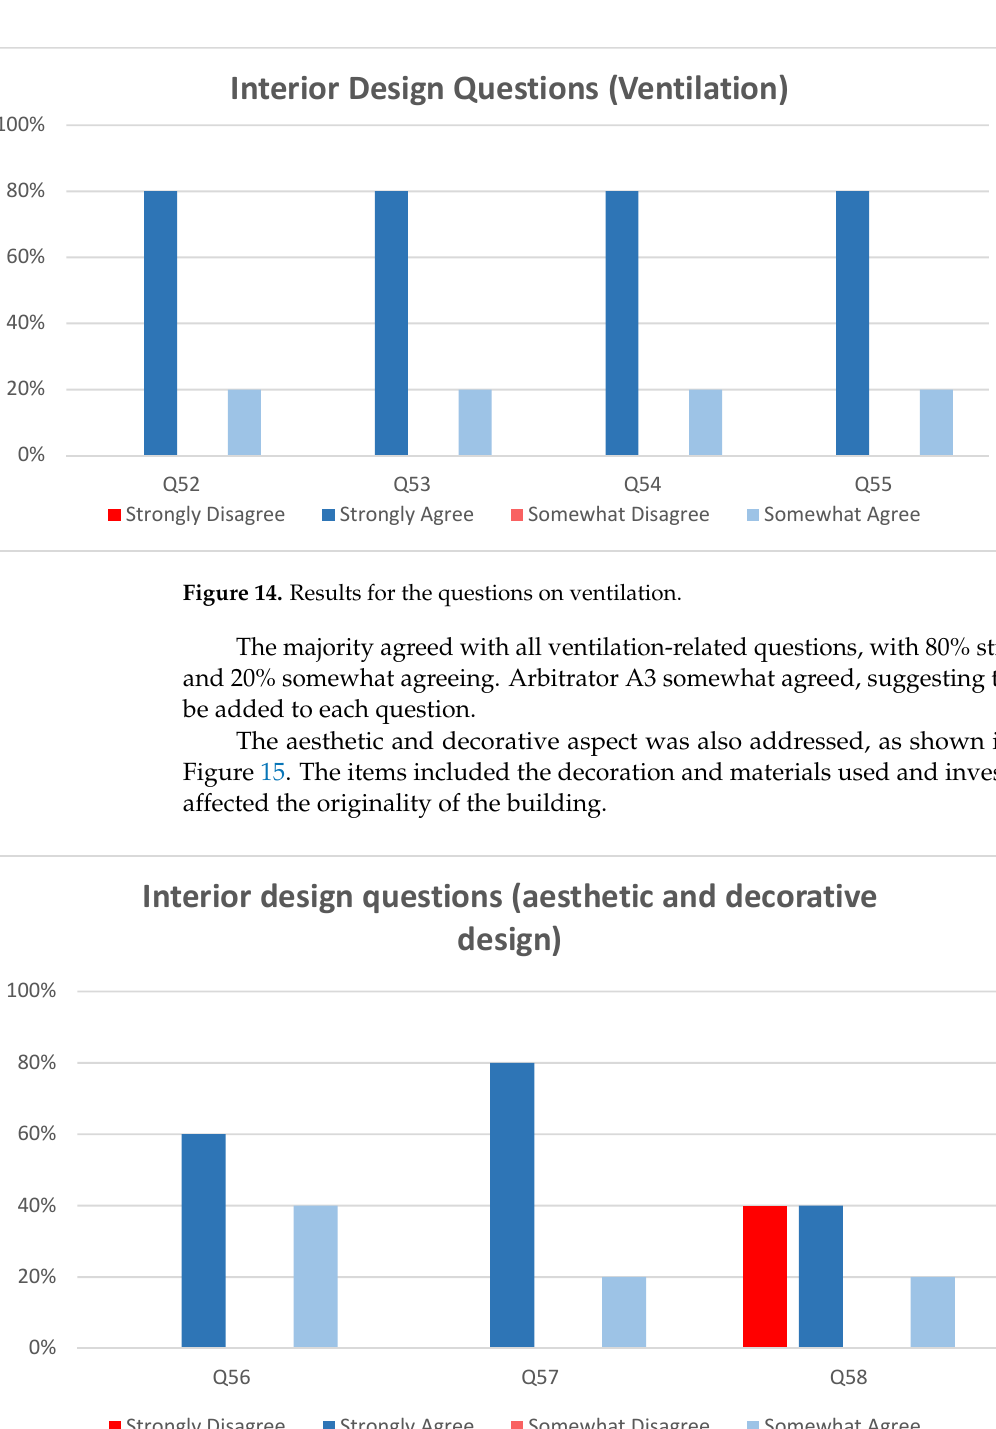
Figure 15. Results for the questions on aesthetics and decorations .